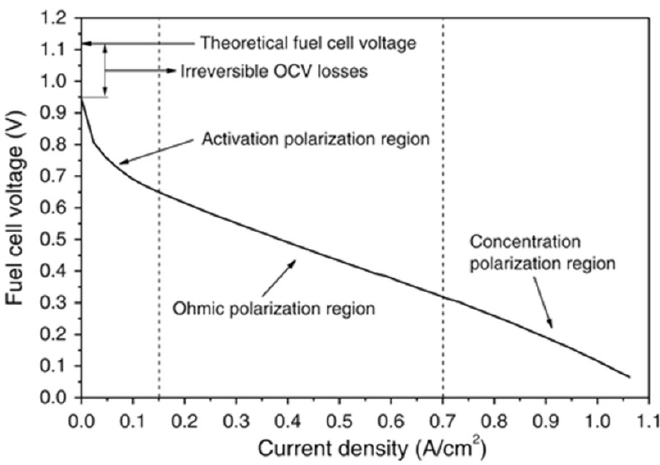
Figure 2. Fuel Cell (FC) polarization curve with voltage losses during FC load [12].